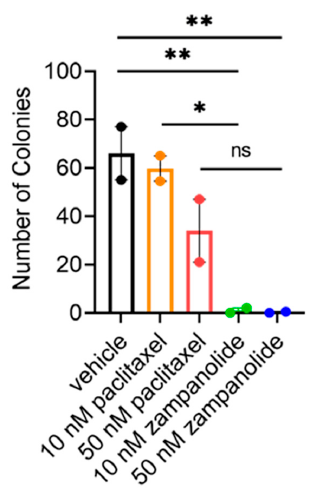
Figure 4. Zampanolide has superior cellular persistence compared to paclitaxel in MDA-MB-231 cells. Quantification of colonies formed by MDA-MB-231 cells 10 days after a 2 h treatment with 10 or 50 nM paclitaxel or zampanolide prior to drug washout. Analysis conducted with one-way ANOVA with Sidak’s multiple comparisons. N = 2 ± SEM. * p < 0.05, ** p < 0.01, ns = no